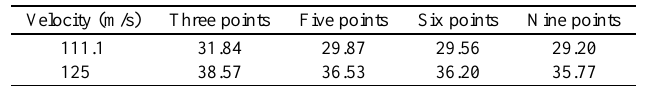
Table 3 The maximal normal displacement at the center on inner surface for different